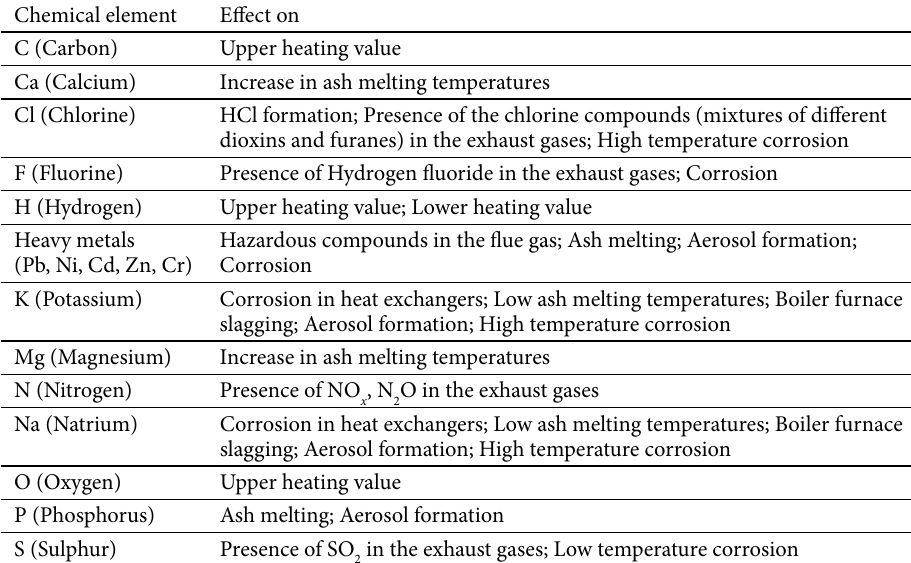
Table 3. Elemental composition of SRC biomass and its chemical exposure Chemical